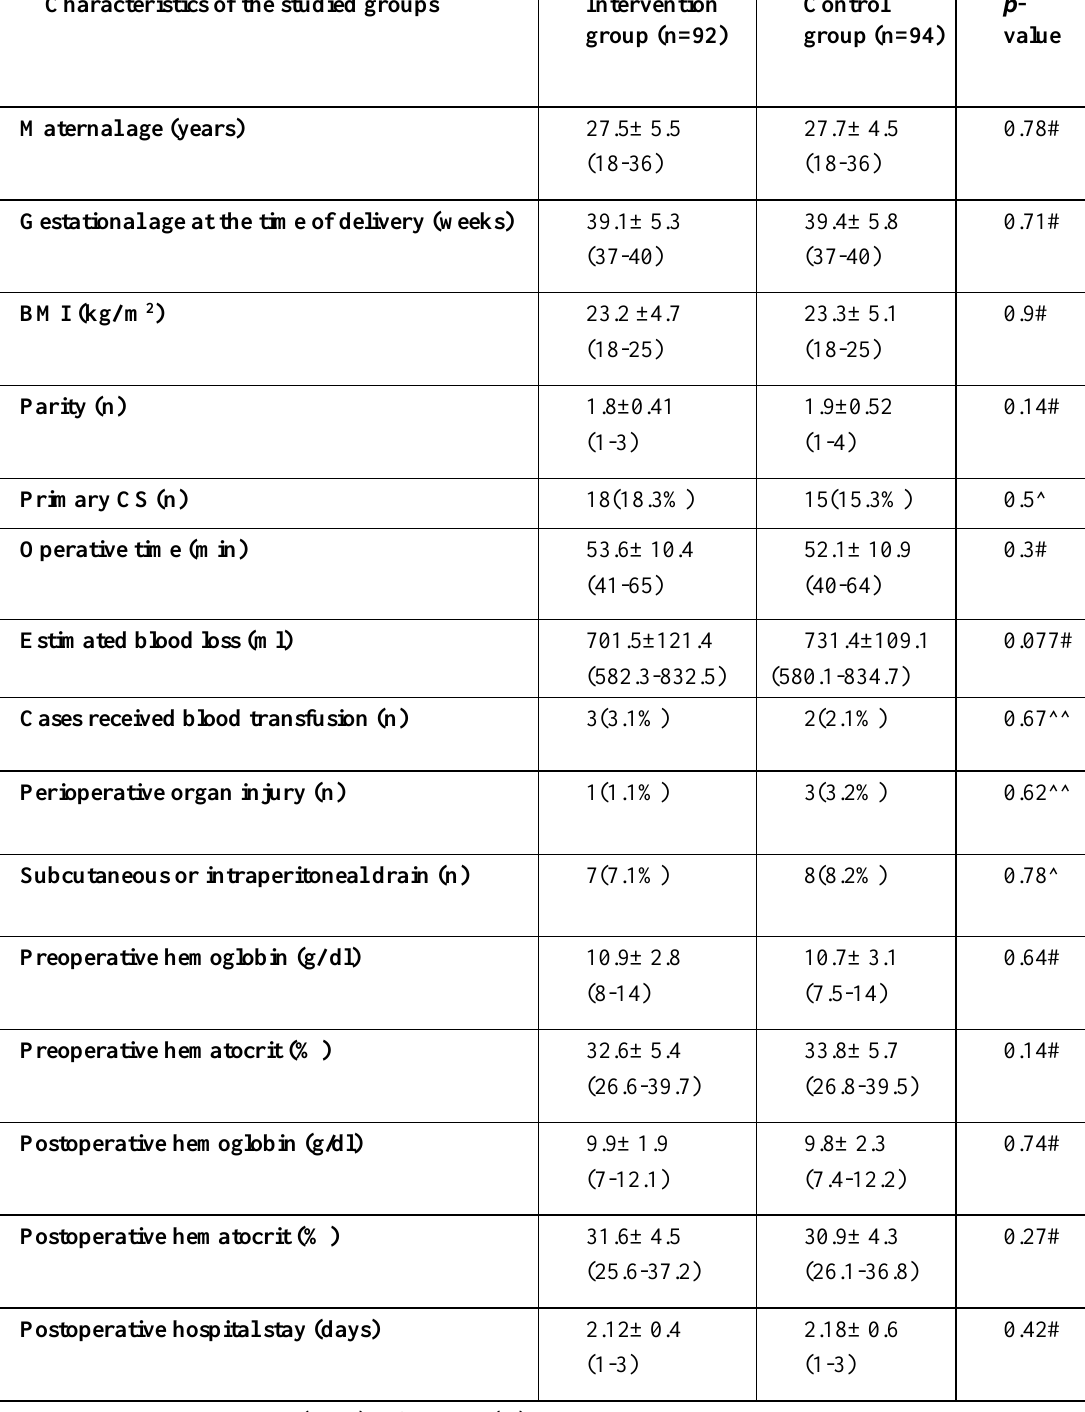
Table 1. Characteristics of the studied